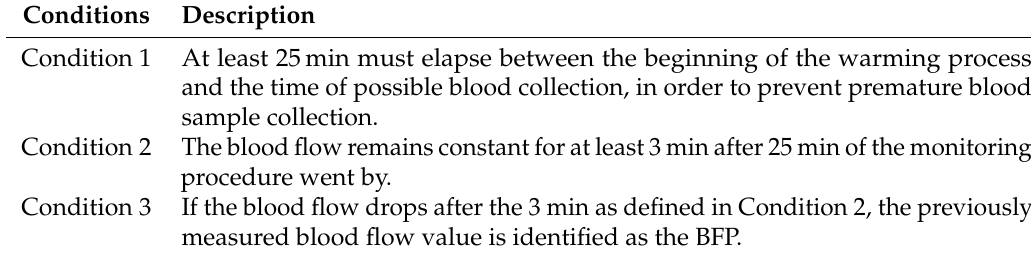
Table 3. Listing of the conditions to be met for computer-aided identification of the BFP.